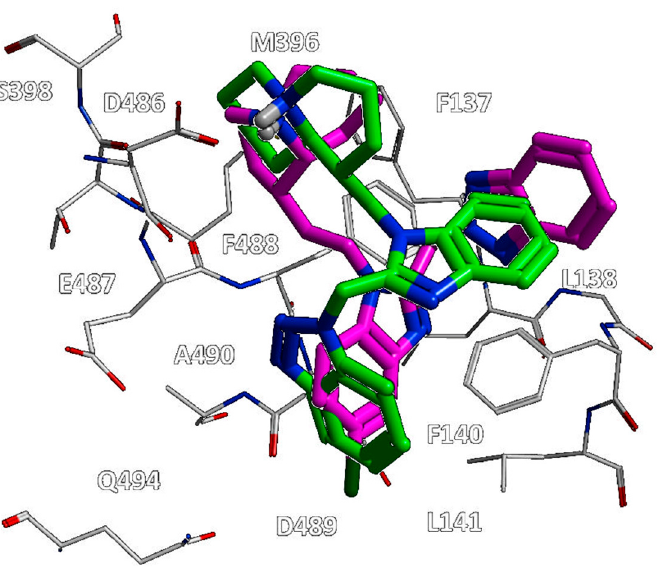
Figure 17. Molecular docking positioning observed for the compounds 118 (C atom; green) and 148 (C atom; magenta) at the RSV F protein surface (PDB code = 5KWW) [24]. The most relevant residues are shown and labelled.